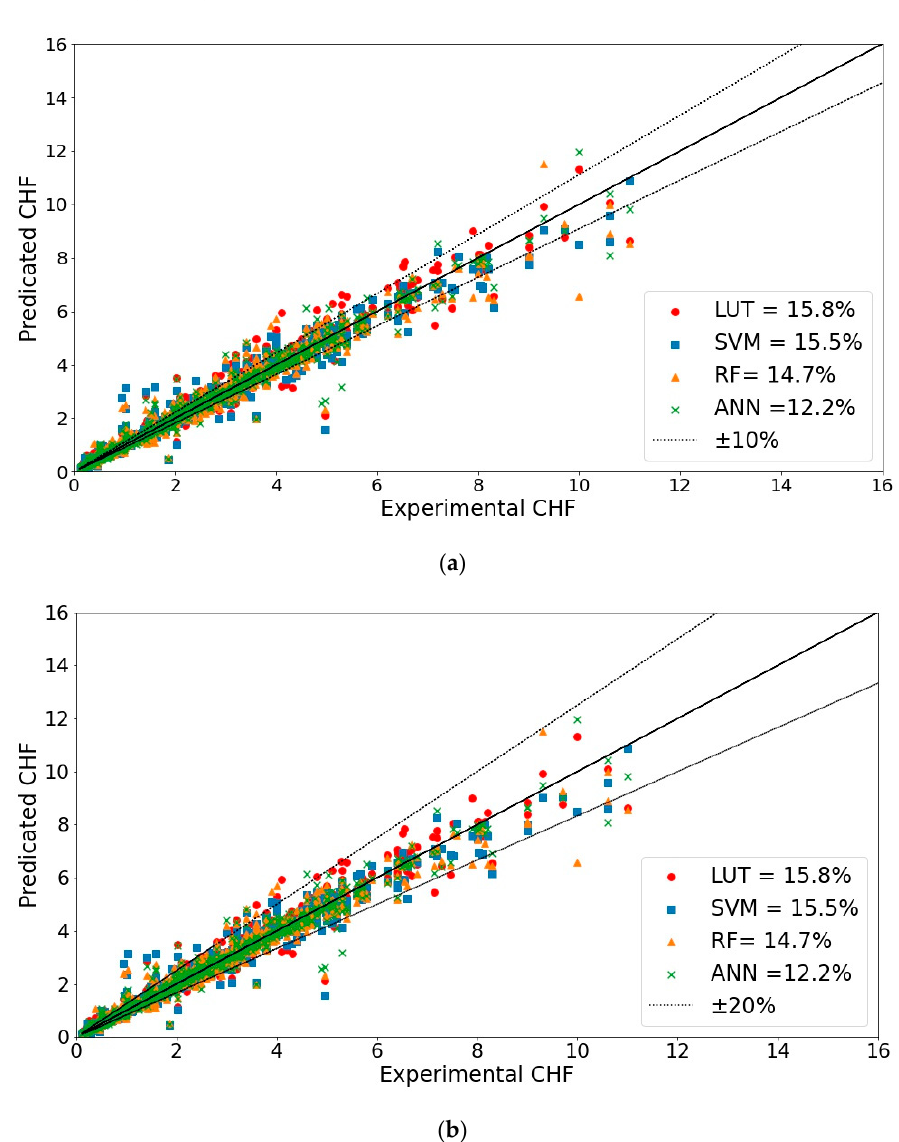
Figure 6. ( a , b ). Experimental vs. predicated CHF for standalone best-estimate models (LUT vs. SVM vs. RF vs.